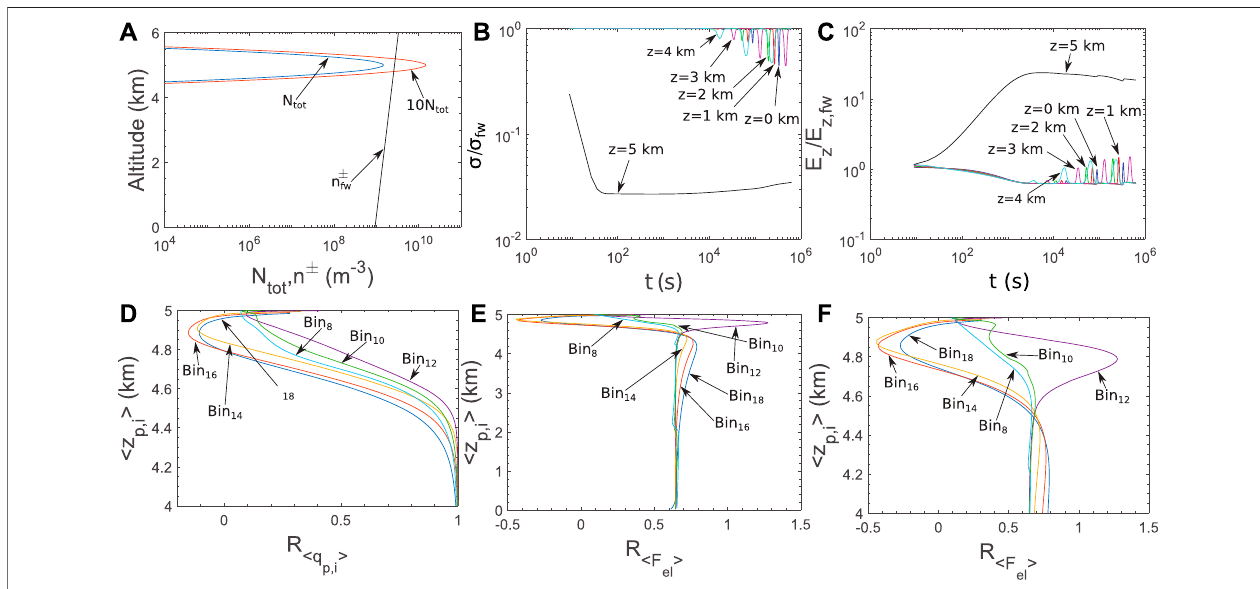
FIGURE 11 | Comparison between the case of N II p , i and the case of10 N II p , i : (A) Total particle number density compared to the ambient fair weather ion density, (B) conductivity reduction with respect to the fair weather value at different altitudes over time for 10 N II p , i , (C) electric fi eld magnitude modi fi cation with respect to the fair weather value at different altitudes over time for 10 N II p , i , (D) average particle charge ratio between N II p , i and 10 N II p , i , for several bins, (E) average electrical force ratio between N II p , i and 10 N II p , i , for several bins, (F) magni fi cation of panel (E) for average altitude range between 4 and 5